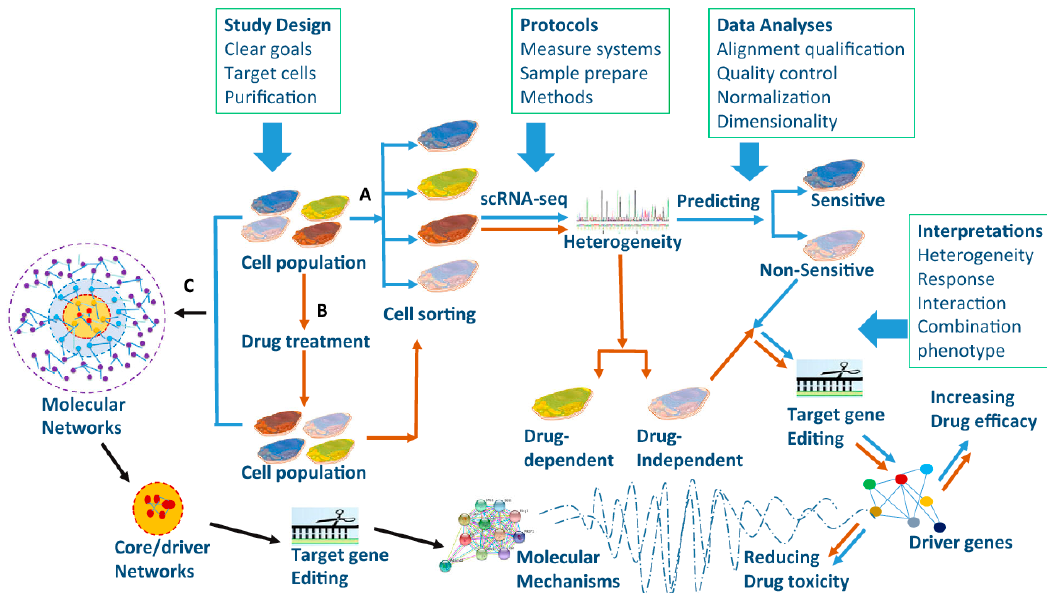
Figure 5. Single-cell RNA sequencing application in drug-response prediction. Targeted cell populations are selected from human organs/tissues and then one type of cell population can be sorted. Drug-dependent gene mutations and drug specificity of targeted genes can be defined after selected cells are treated with drugs (B, brown arrows). On the other hand, gene sequences and epigenetics of selected cells can be measured before the cell sorting (C, black arrows) to compare the cell population with single-cell sequences. Molecular mechanisms, drug efficacy, and toxicity of identified core/driver genes and networks can be validated by editing target genes. Reprinted with permission from ref. [157]. Copyright 2017 SpringerLink.